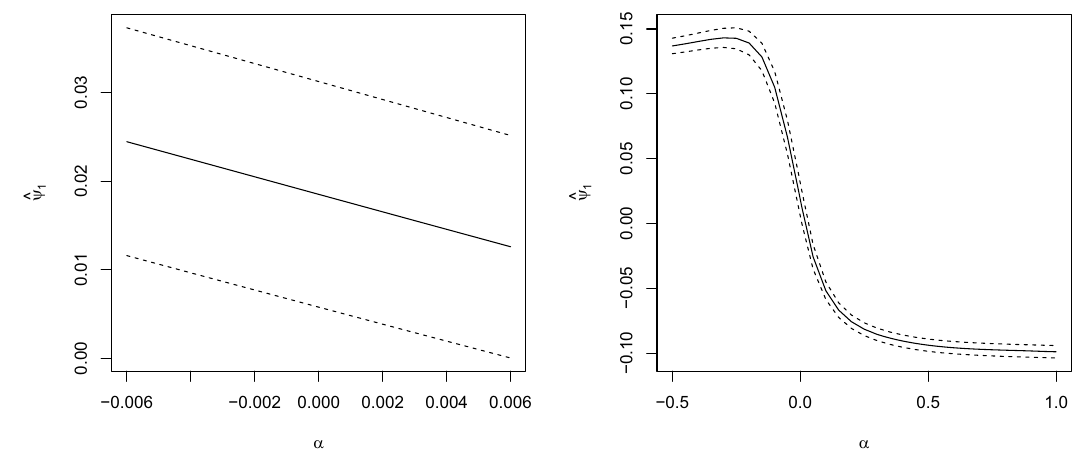
Figure 3: The estimated marginal causal log odds ratio ( solid lines ) for systolic blood pressure and CHD together with pointwise 95% con fi dence limits ( dashed liness ) , as functions of the sensitivity parameter α